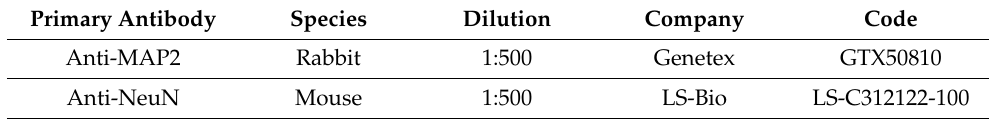
Table 2. Primary antibodies